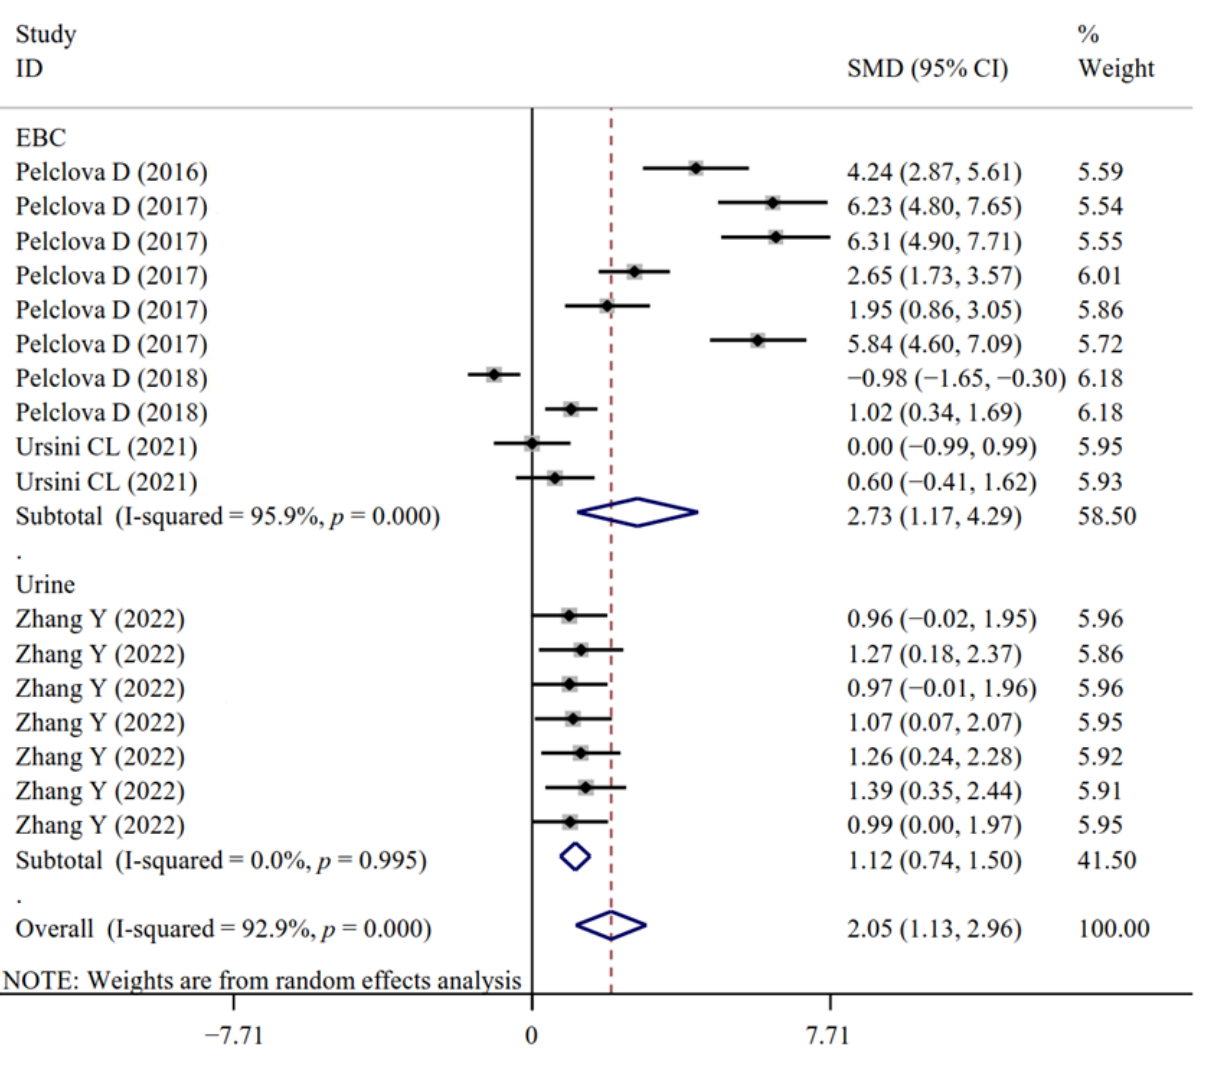
Figure 7. Forest plots assessing the effects of exposure to different NMs on the level of HNE in different samples compared with the non-exposed control group. NMs, nanomaterials; EBC, exhaled breath condensate; HNE, 4-hydroxy-2-nonhenal; SMD, standardized mean difference; CI, confidence interval